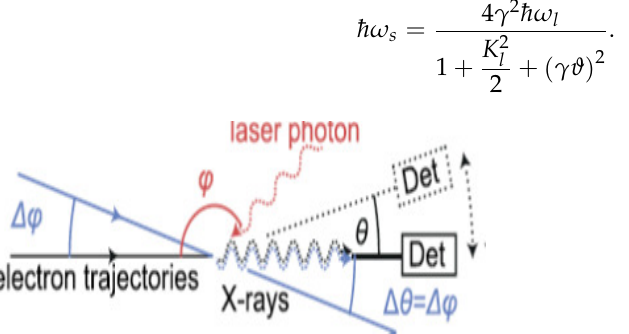
Figure 7. Geometry of the Compton Backscattering including angular